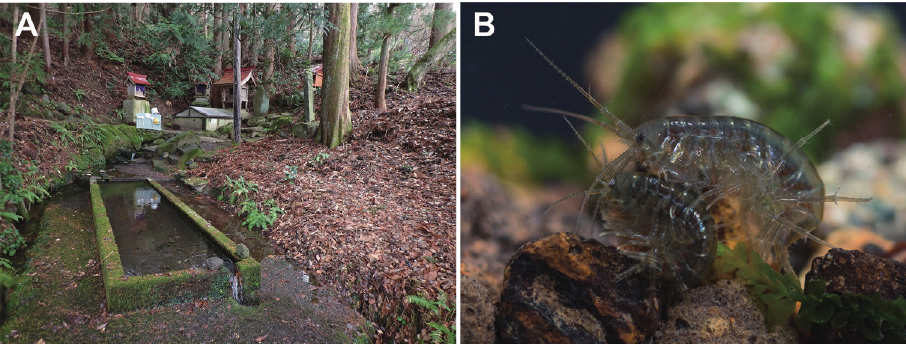
Figure 1. Habitat and live specimens of Jesogammarus ( Jesogammarus ) acalceolus sp. nov. A the type local- ity, Haguro Shrine Spring, Hirosaki, Aomori Prefecture, Japan B mate guarding pair, male is upper and female is lower, photographed by Ryu